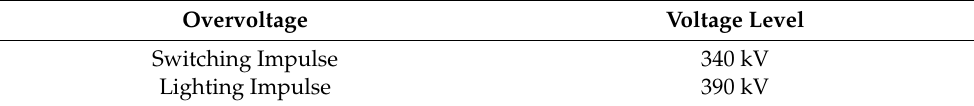
Table 1. Overvoltage characteristics calculated through an insulation coordination analysis [13].